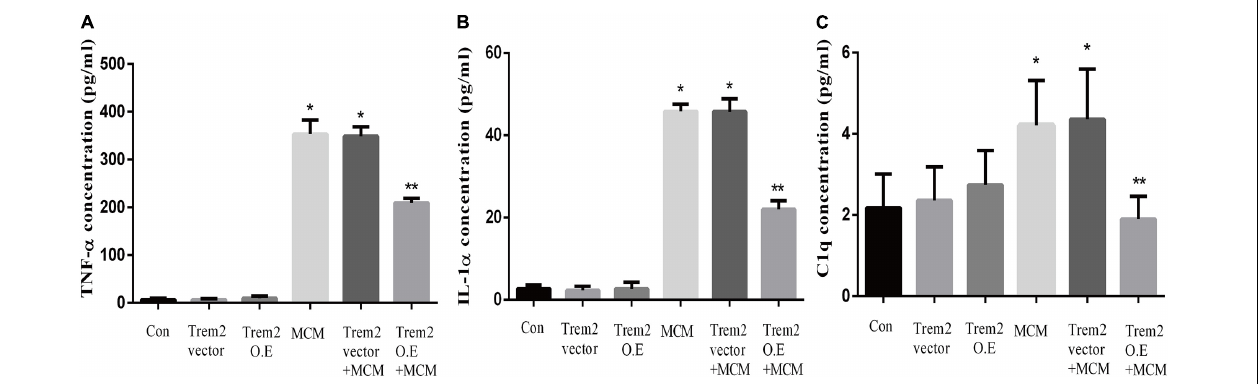
FIGURE 8 | Concentrations of IL-1 α , TNF- α , and C1q were tested in MCM, Triggering receptor expressed on myeloid cells 2 (TREM2) (vector or overexpression) transfection-conditioned mediums, and TREM2 (vector or overexpression) + MCM. The concentration levels were measured using ELISA kits. (A) Concentration of TNF- α . (B) Concentration of IL-1 α . (C) Concentration of C1q. Differences between the means were determined by t test. * p < 0.05 versus control at the match time point, ** p < 0.05 versus LPS (0.1 ug/m) at the match time point. The data are expressed as means ± SEM from three independent experiments. C1q: complement